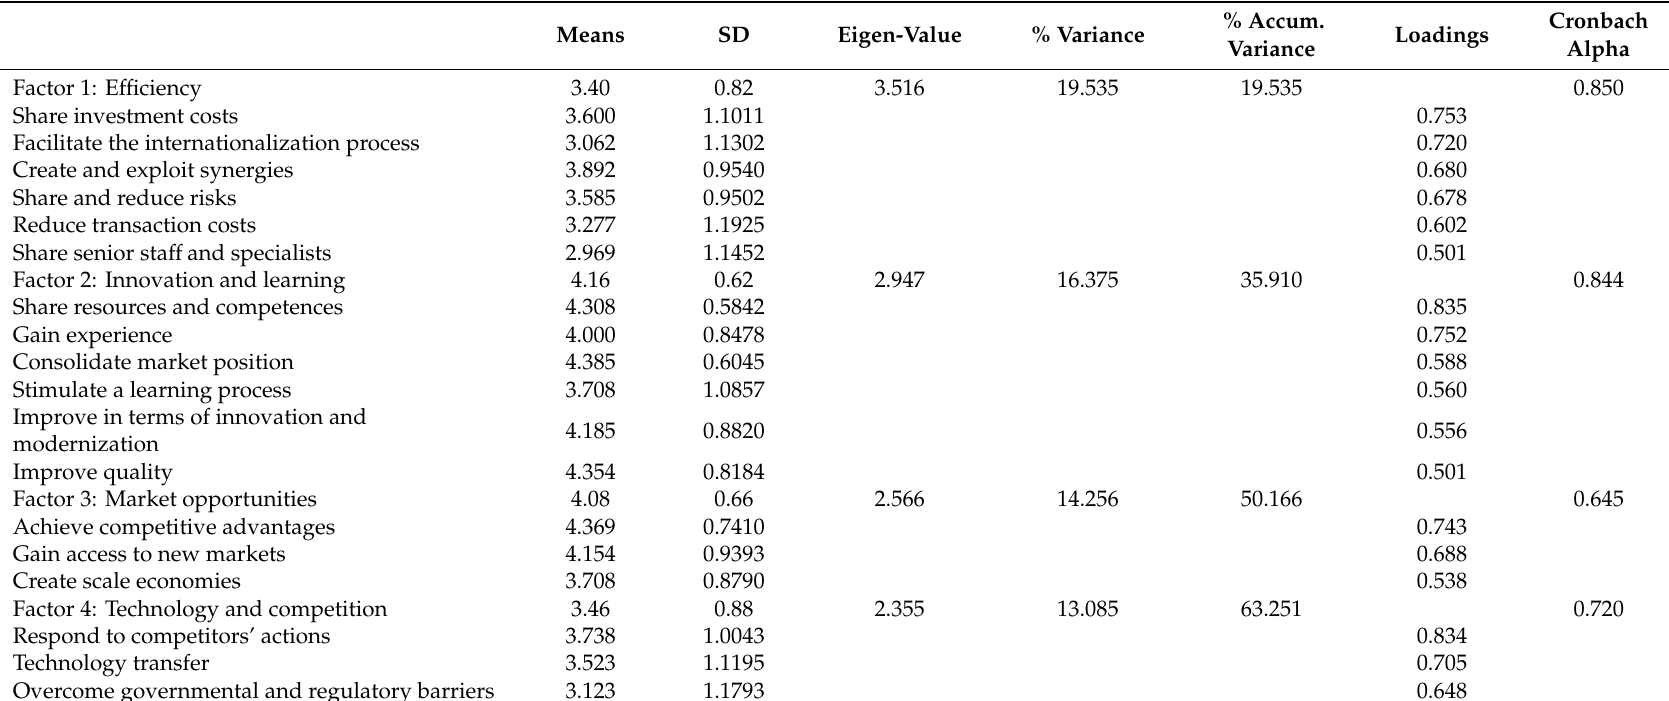
Table 3. Factor Analysis of Motives for Interfirm